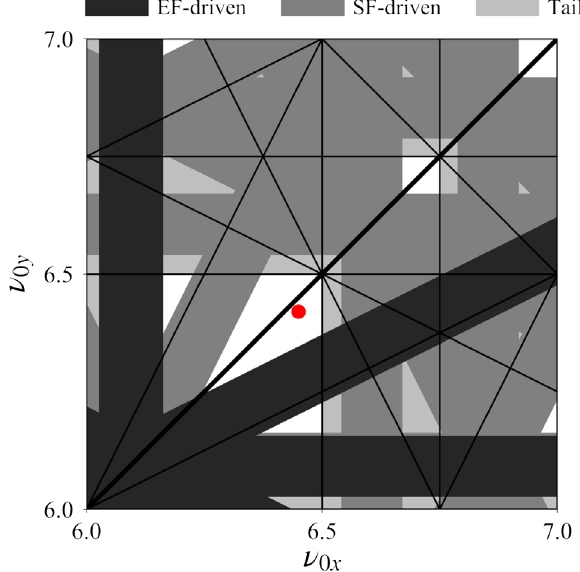
FIG. 19. Stability tune diagram based on the fundamental parameters of the RCS at J-PARC. The three different types of instability bands, produced by the self-field-driven, external- field-driven, and tail-induced resonances, are plotted up to the third order. The coherent resonance condition in Eq. (9) has been used together with the tune-shift factors C 2 ¼ 0 . 75 and C ¼ 0 . 80 . The rms tune depression is fixed at 0.98, considering 3 the beam parameters after the transverse injection painting at the RCS. For the sake of simplicity, all stop bands are assumed to have an identical width except for the symmetric difference resonance along ν 0 x − ν 0 y ¼ 0 (thick solid line) where the coupling effect should be less dangerous under the operating condition of the RCS. The thin solid lines show the positions of the resonances at zero-intensity limit ( η → 1 ). A red dot on the picture indicates the typical operating point of the RCS, i.e., ð ν ; ν Þ ¼ ð 6 . 45 ; 6 . 42 Þ 0 x 0 y